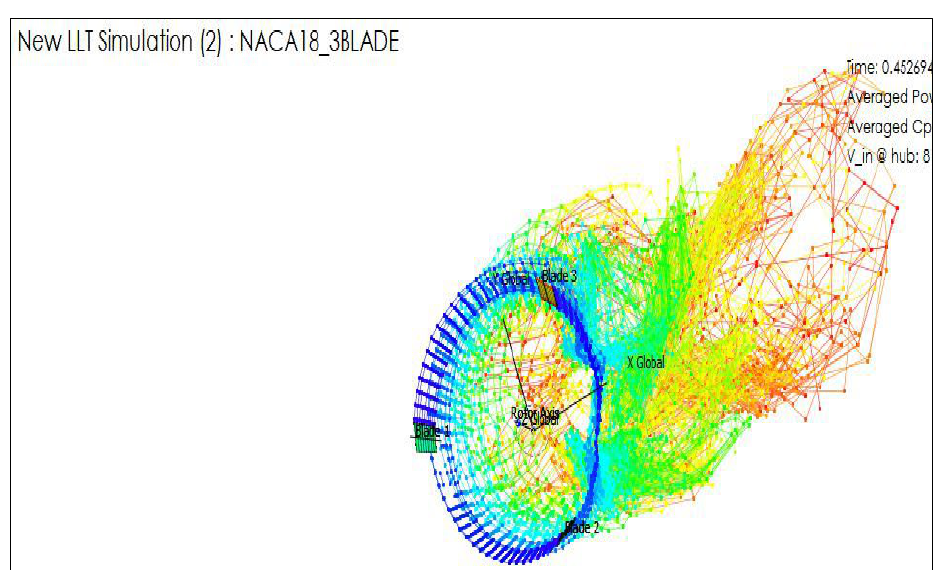
Figure 52. All effects vortex simulation